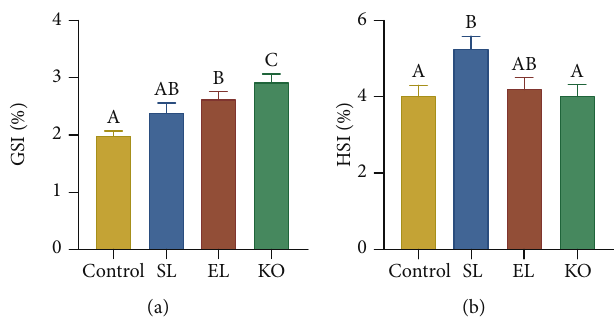
Figure 1: Hepatosomatic index and gonadosomatic index of Cherax quadricarinatus fed control, soybean lecithin (SL), egg yolk lecithin (EL), and krill oil (KO) diets for 10 weeks. (a) Gonadosomatic index. (b) Hepatosomatic index. Data are expressed as the mean ± SEM (standard error of the mean) ( n = 20 , individuals). Di ff erent uppercase letters (A, B, and C) indicate signi fi cant di ff erences ( P < 0 : 05 ) ( C > B > A ). HSI = hepatosomatic index; GSI = gonadosomatic index.